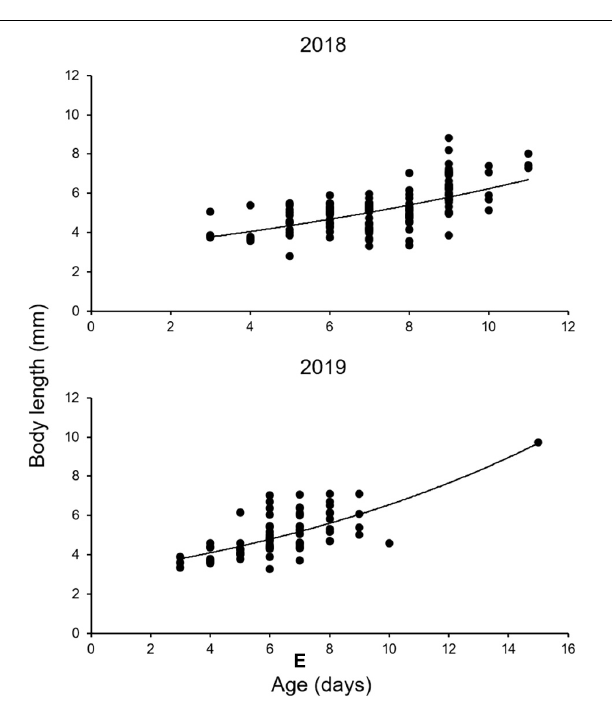
FIGURE 8 | Growth of Scomber japonicus larvae in the northern Satsunan area in 2018 and 2019, based on daily increments in sagittal otoliths. The regression equations and growth coefficients are shown in Table 3